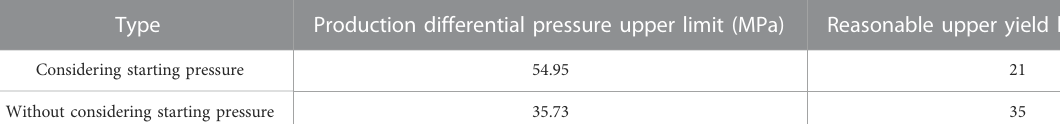
TABLE 1 Statistical comparison of different models.